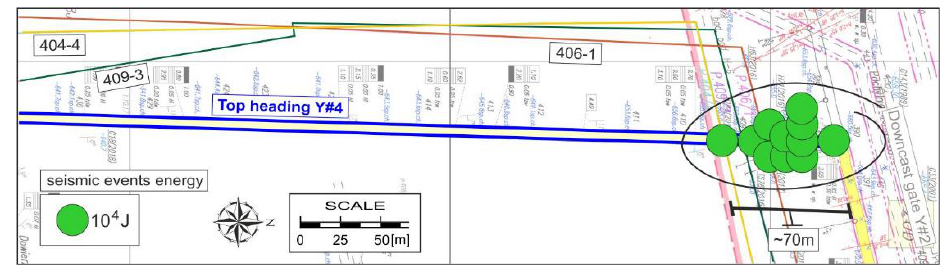
Figure 5. Distribution of seismic events with energy E ≥ 10 4 J during the drifting of top heading